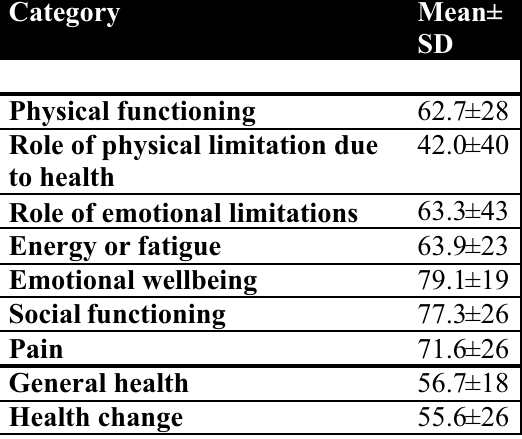
Table 05. Distribution of different sub categories of HRQoL among the study